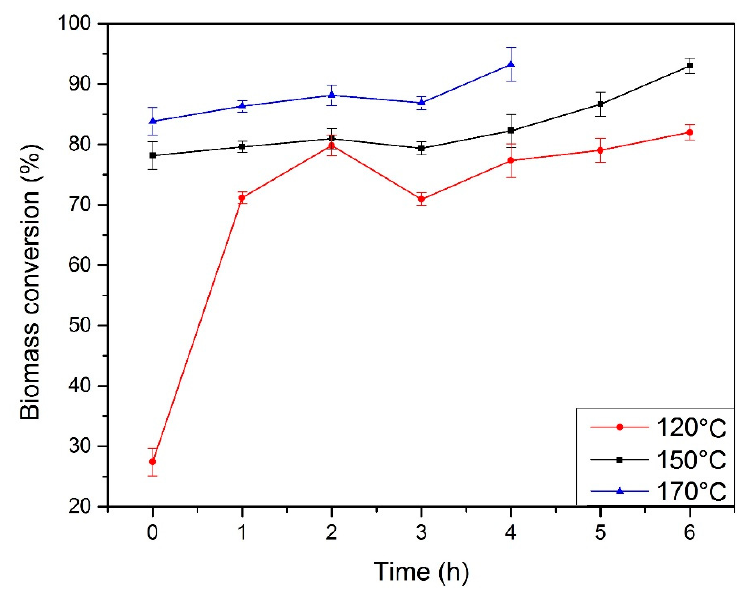
Figure 3. Change of biomass conversion of polyols.